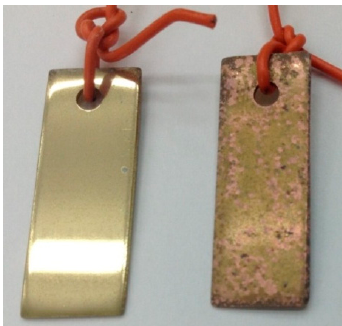
Figure 10. Samples (inhibited-left, uninhibited-right) for XPS-studies after 20 cycles in the salt fog chamber.